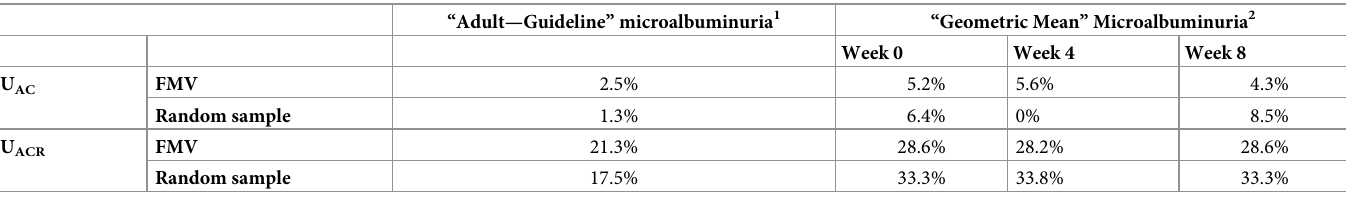
Table 3. Prevalence of microalbuminuria.